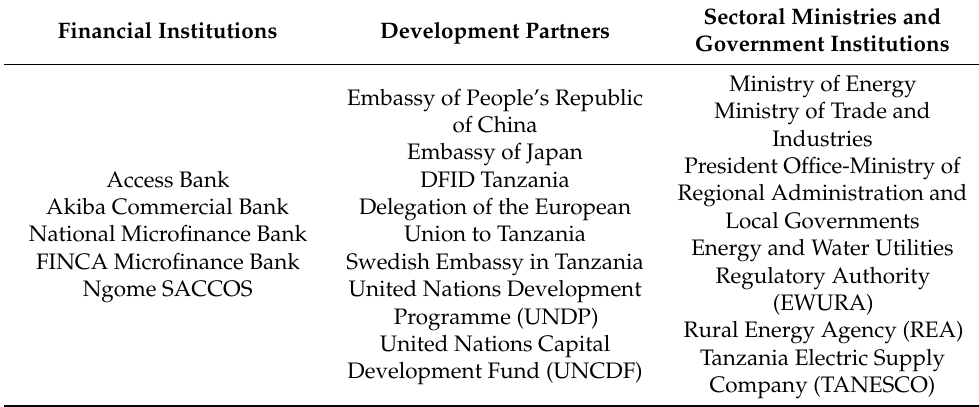
Table A1. List of institutions with which interviews were conducted to understand the eCooking enabling